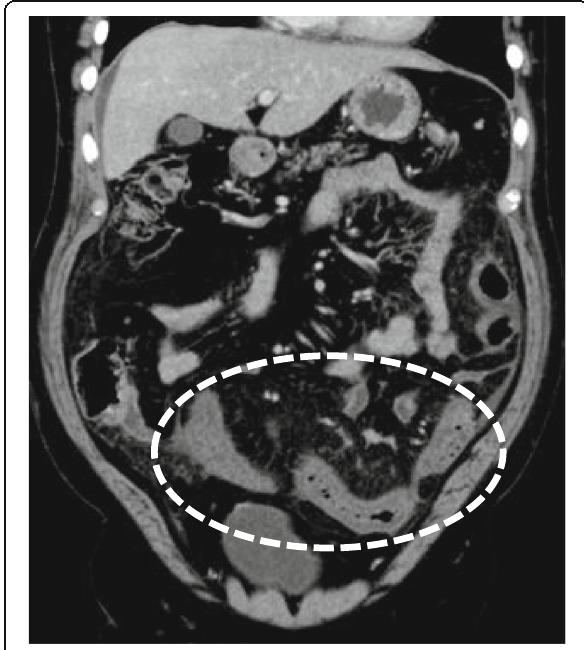
Fig. 1 Portal venous-phase CT of the abdomen demonstrating marked wall thickening with poor mural enhancement and extensive submucosal edema in the sigmoid colon (white dotted